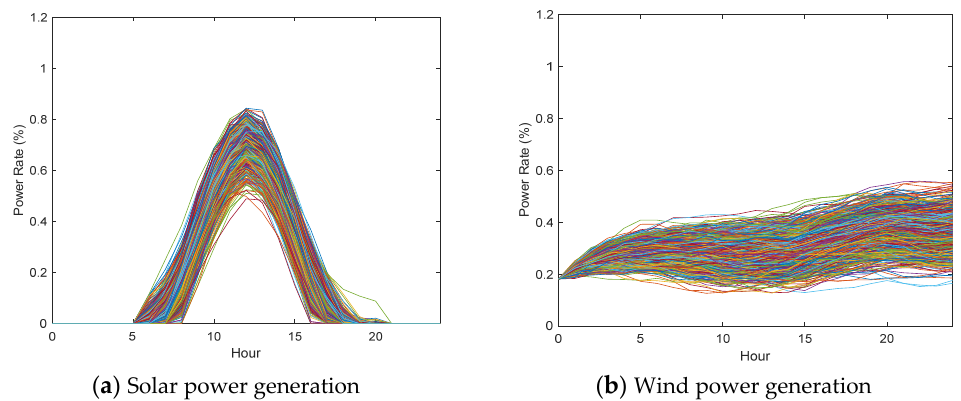
Figure 2. One thousand simulated forecast profiles of solar and wind power generation.